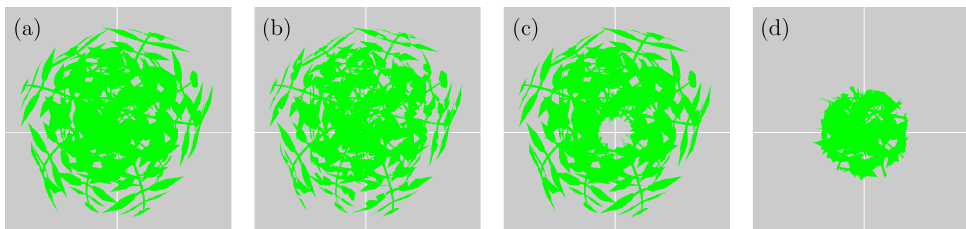
Figure 4. Top-view visualization of the tomato plant model for the three thinning scenarios: ( a ) the original complete plant, ( b ) random thinning, ( c ) inside to outside thinning, and ( d ) outside to inside thinning, all at